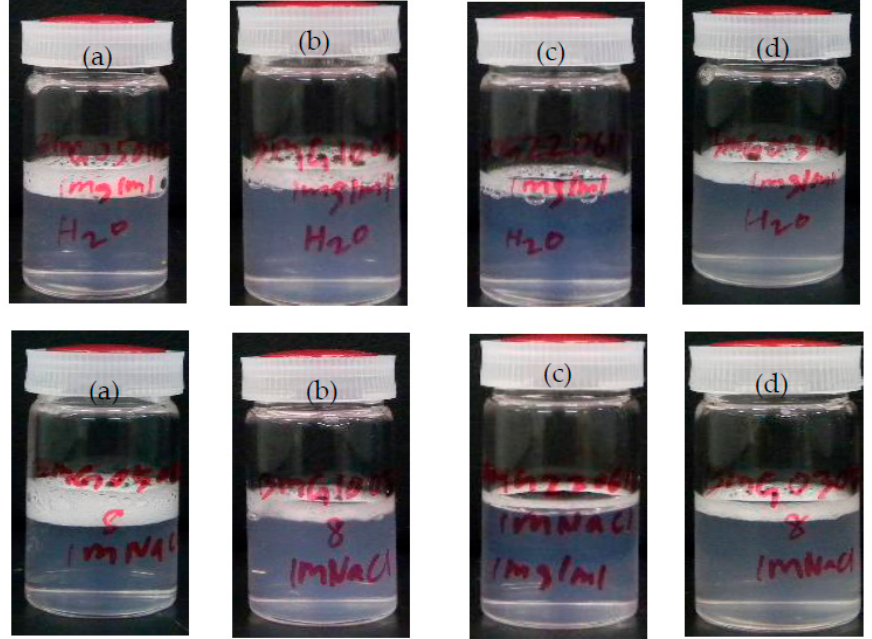
Figure 3. Influence of chain length and salt on foam forming abilities of different ZABCs containing P( n -BMA): ( a ) n -BMA 35 - b -GLBT 55 ; ( b ) n -BMA 62 - b -GLBT 117 ; ( c ) n -BMA 101 - b -GLBT 156 ; and ( d ) n -BMA 42 - b -GLBT 300 of concentration (1 mg/mL) in water ( top row ) and 1 MNaCl ( bottom row ).